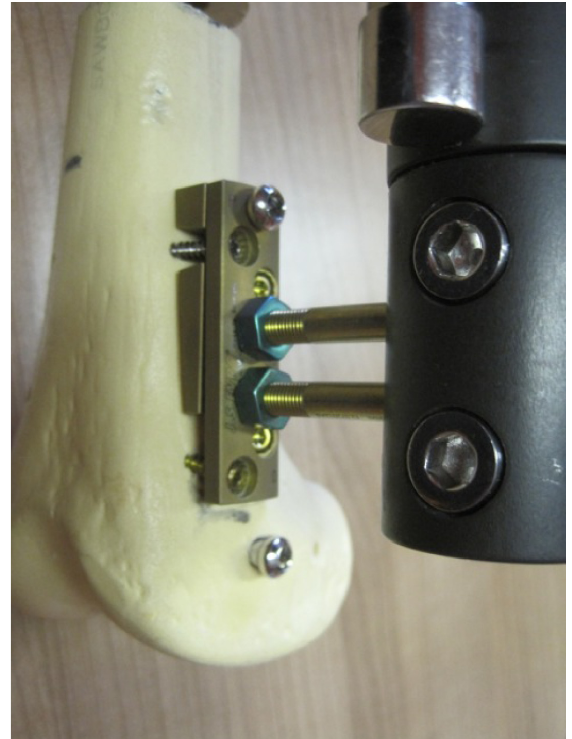
Figure 2. ONAS-DPS. Two plates are needed distally (Figure 1) since the femoral metaphysis is curved: the lower plate (subplate) is a specially designed ‘‘wedge plate’’ which makes the unilateral external fixator parallel to the bone. If ONAS-DPS is used with anterograde IM nail the wedge plate must be used proximally (not shown). Wedge plates with four different angles (thicknesses) are available with ONAS-DPS, each having an equivalent probe. The upper plate provides fixation to the bone with four angle stability screws. Each screw hole in the plate offers the possibility of placing the screw at any chosen angle from 90 (cid:3) to 65 (cid:3) with respect to the sagittal axis of the bone. Please note that the IM nail is in the medullary canal and that the plates are fixed with screws going anteriorly and posteriorly with respect to the IM nail. Proximally, a separate screw passes through both plates and cortical bone and goes through the IM nail and finally anchors into the opposite cortical bone. The two-plate system of the ONAS-DPS enables stable fixation of Schanz screws and also stable fixation of both plates to the bone, in this way avoiding direct contact between Schanz screws and IM nail, which is responsible for the high incidence of infection in standard